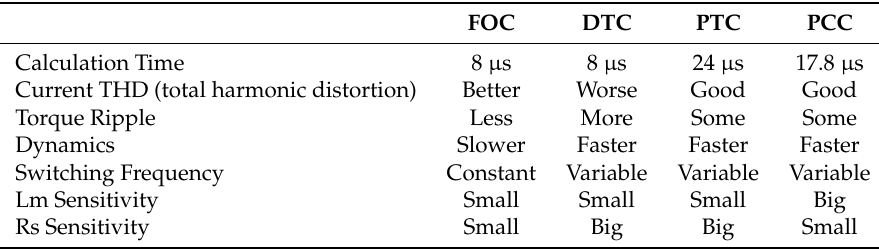
Table 3. Comparative issues in